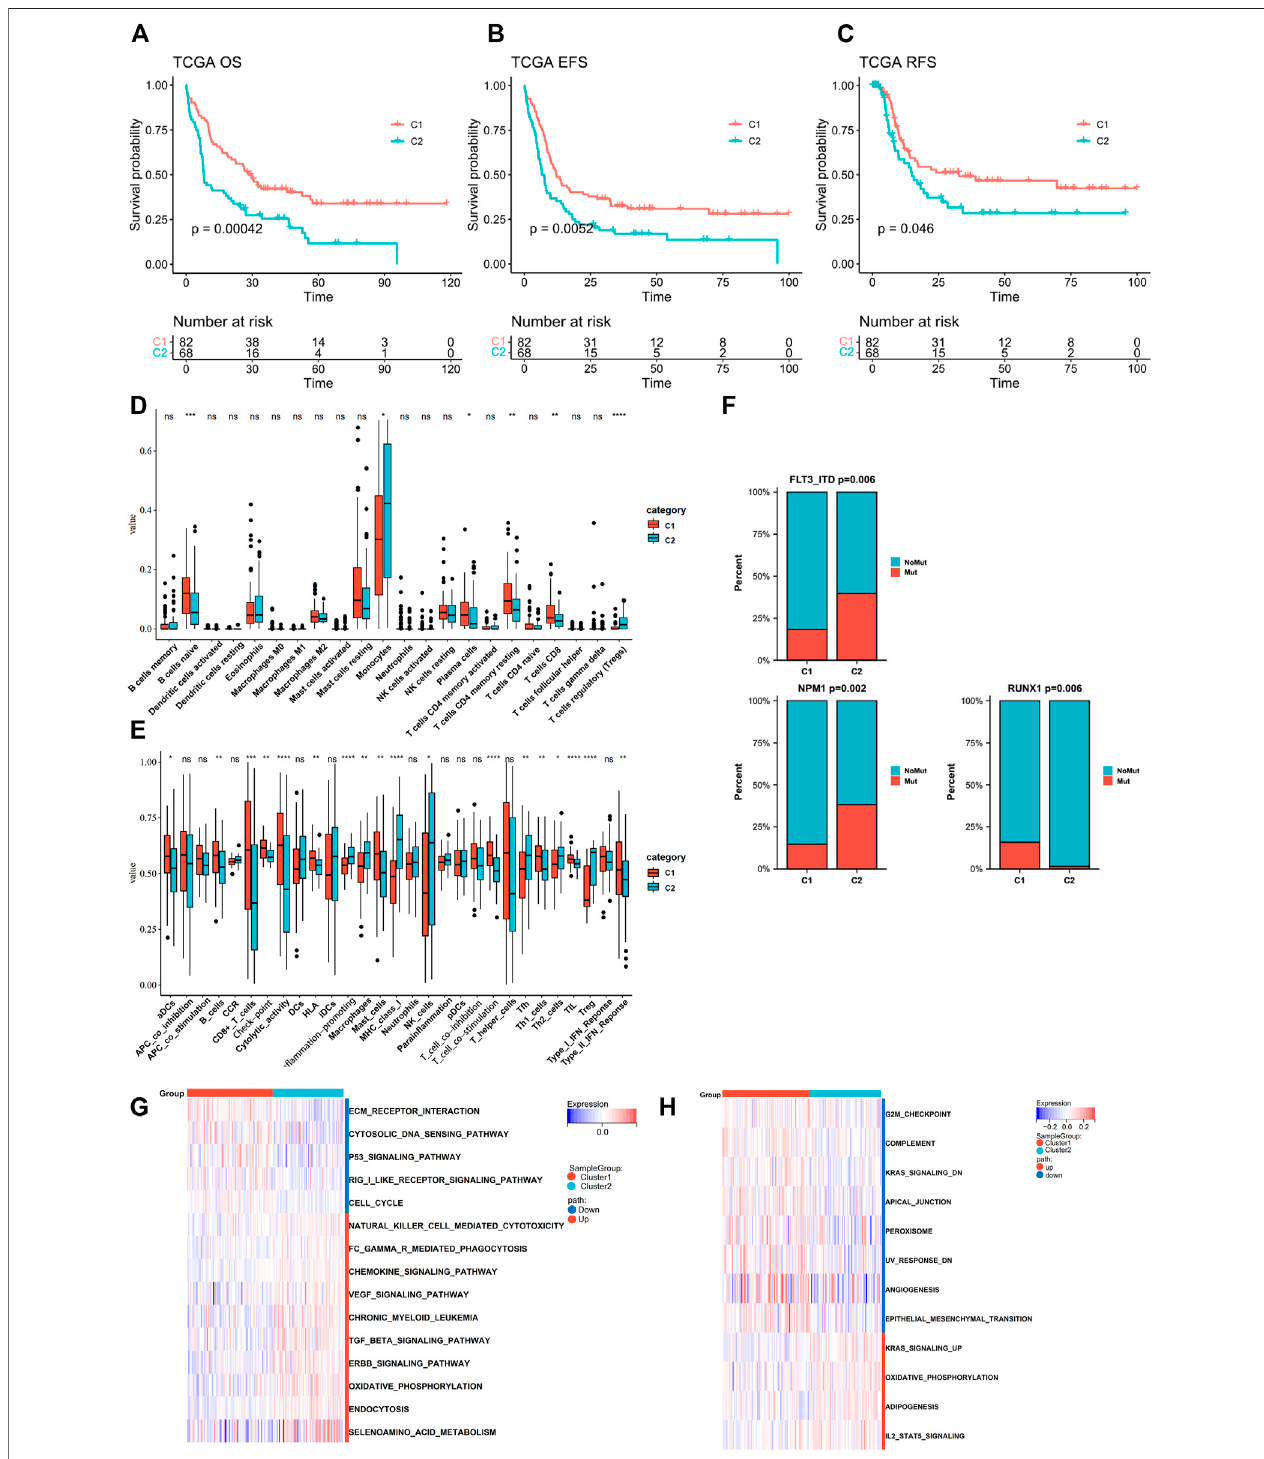
FIGURE3 | Assessmentof differences in prognosis, immune elements, and pathway enrichmentbetweenthe two subtypes in TCGA cohort. (A – C) Kaplan – Meier survival analysis of the two clusters in TCGA (OS, overall survival; EFS, event-free survival; RFS, relapse-free survival. C1 n = 82, C2 n = 68; log-rank p-test). (D , E) Comparison of the difference in immune cell fraction and immune response between the two subtypes, with CibersortX and ssGSEA algorithm (Wilcoxon tests). (F) FLT3-ITD, NPM1, and RUNX1 mutation distribution between the two subtypes (Chi-Square tests). (G , H) Heatmaps of GSVA-based KEGG and Hallmark analysis of the two subtypes (Wilcoxon